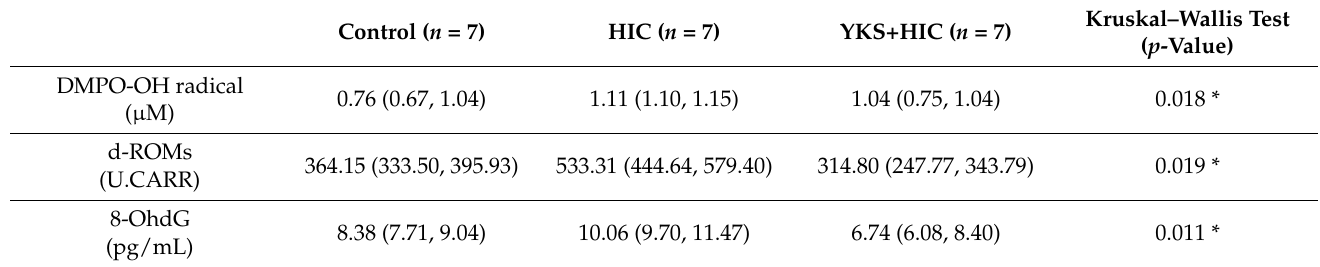
Table 2. Oxidative Stress Parameters.